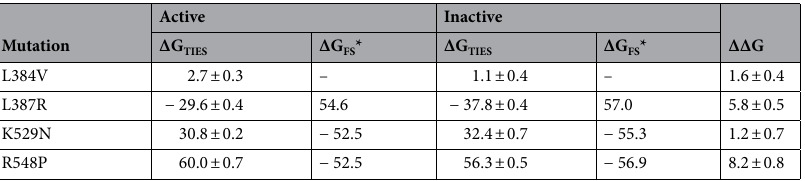
Table 3. Relative conformational free energy changes (cid:31)(cid:31) G = (cid:31) G act TIES − (cid:31) G inact TIES between the active and inactive states upon a mutation. ΔΔG > 0 means that the free energy change in the active state is larger than that in the inactive state (Fig. 2). All energy values are in kcal/mol. *Finite size correction, related to the size of simulation box; the error associated is negligible.